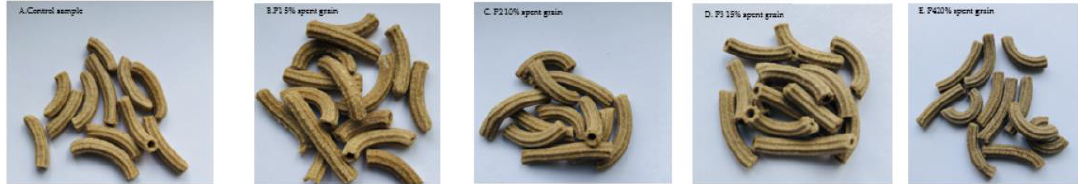
Figure 2. Appearance of dry pasta color. ( A ) Control sample, ( B ) Pasta made with 5% spent grain addition, ( C ) Pasta made with 10% spent grain addition, ( D ) Pasta made with 15% spent grain addition, ( E ) Pasta made with 20% spent grain addition.